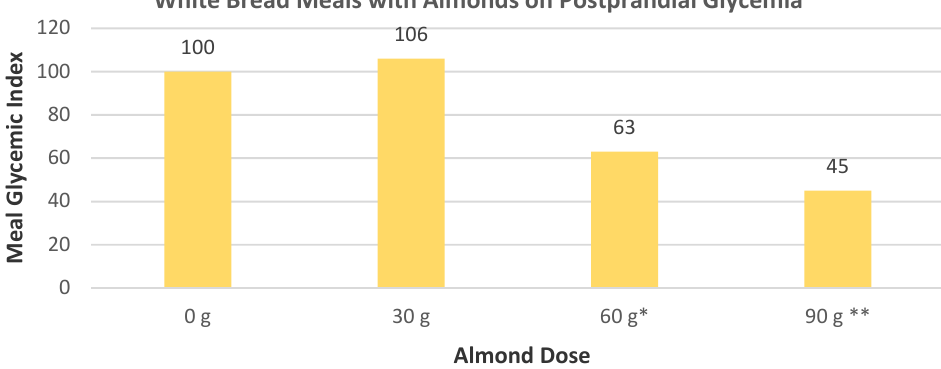
Figure 18. Dose–response effect of increasing level of almonds consumed with white bread on glycemic index over 120 min (* p < 0.02, ** p < 0.01) [74]. Jenkins et al. [75], in parallel RCTs, randomized 15 healthy subjects (7 men and 8 women, mean age 26 years, mean BMI 23) into one of two diet groups: (1) 97 g white bread (control) or (2) the control with 60 g of almonds, followed by frequent measures of post- prandial blood glucose, serum insulin, and protein thiol (which is protective against pro- tein oxidative damage) for 240 min. Compared to the white bread control group, the com- bination of almonds plus white bread reduced peak glucose by − 14% ( p < 0.001), insulin by − 31% ( p ≤ 0.042), and increased serum protein thiol levels by 15 mmol/L ( p = 0.021). Adding almonds to parboiled rice and instant mashed potatoes had similar effects as shown for white bread. Almond’s effect of increasing postprandial protein thiol levels protects against reactive oxygen species (ROS) such as oxidized LDL-C and vascular en- dothelial protein damage to help reduce coronary heart disease (CHD) risk. Bhardwaj et al. [76], in a crossover, controlled feeding RCT, randomly assigned 27 overweight subjects (16 women and 11 men, mean age 42 years, mean BMI 29, normal blood pressure) into test diets of 1150 kcal meals consisting of sandwiches of white bread, salami, fatty cheese, full-fat yogurt, and water, plus walnuts (60 g) or almonds (76 g) to match the fat content. Vascular endothelial function measurements were taken over 4 h. Both almonds and walnuts similarly improved flow-mediated dilation (FMD) and de- creased soluble vascular cellular adhesion molecules’ (sVCAM) function with no signifi- cant difference between the two nuts ( p ≤ 0.51). Vascular endothelial dysfunction has been implicated in early and advanced atherosclerosis related to perfusion abnormalities and ischemic events. Four to Six Weeks Duration Lovejoy et al. [32], in a parallel RCT, randomly assigned 20 healthy adults (10 men and 10 premenopausal women, mean age 25 years, mean BMI 23) to receive 100 g/day of whole almonds alone or mixed with a variety of foods (e.g., trail mix, cookies, or muffins) plus their habitual diet for 4 weeks. Almonds significantly decreased TC ( − 21%) and LDL- C ( − 29%) from baseline ( p < 0.05 for both). TG was not significantly altered from baseline. HDL-C decreased significantly from baseline and was significantly lowered in men com- pared to women. Both TC:HDL-C and LDL-C:HDL-C ratios decreased with almond sup- plementation. In women, almonds tended to improve insulin sensitivity ( p = 0.09) com- pared to baseline levels. Lee et al. [77], in a crossover, controlled feeding RCT, randomized 31 healthy over- weight and obese individuals (13 women and 18 men, mean age 46 years, mean BMI 30) into isocaloric (2100 kcal/day) diets based on: (1) the average American control diet, (2)